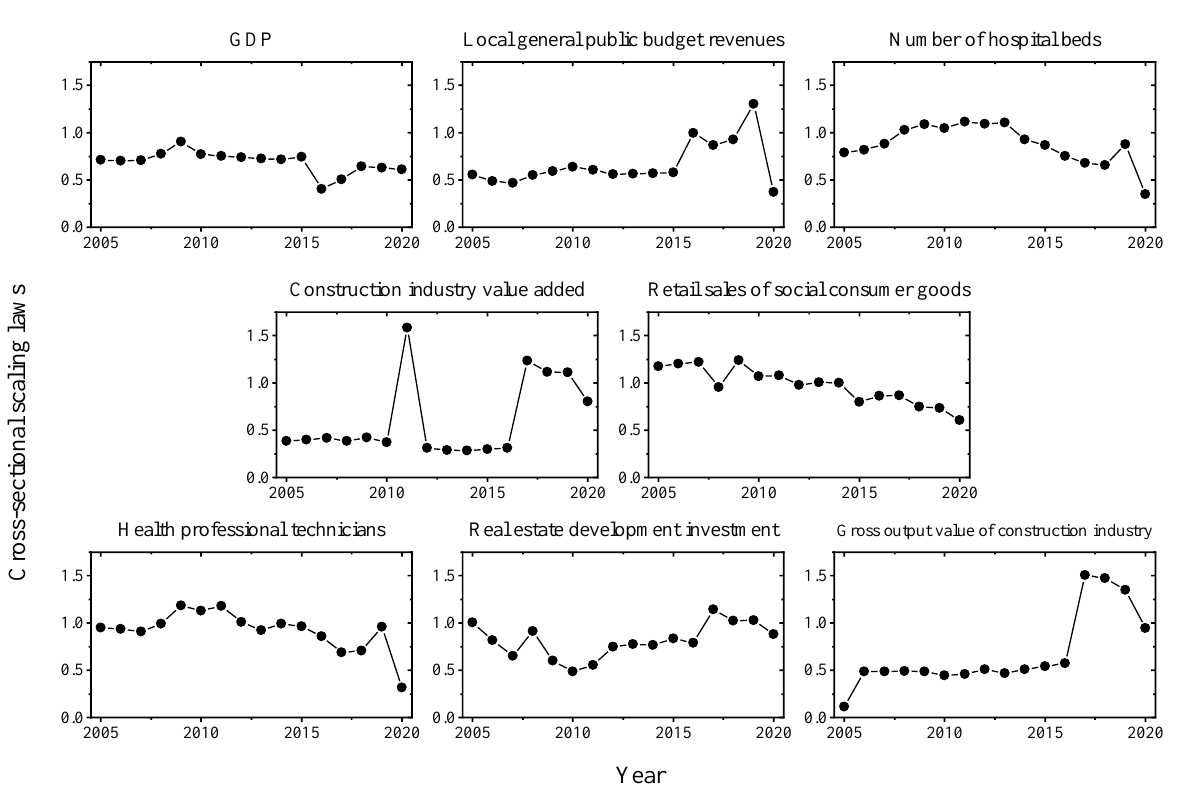
Figure 4. Cross-sectional scaling law of each region.